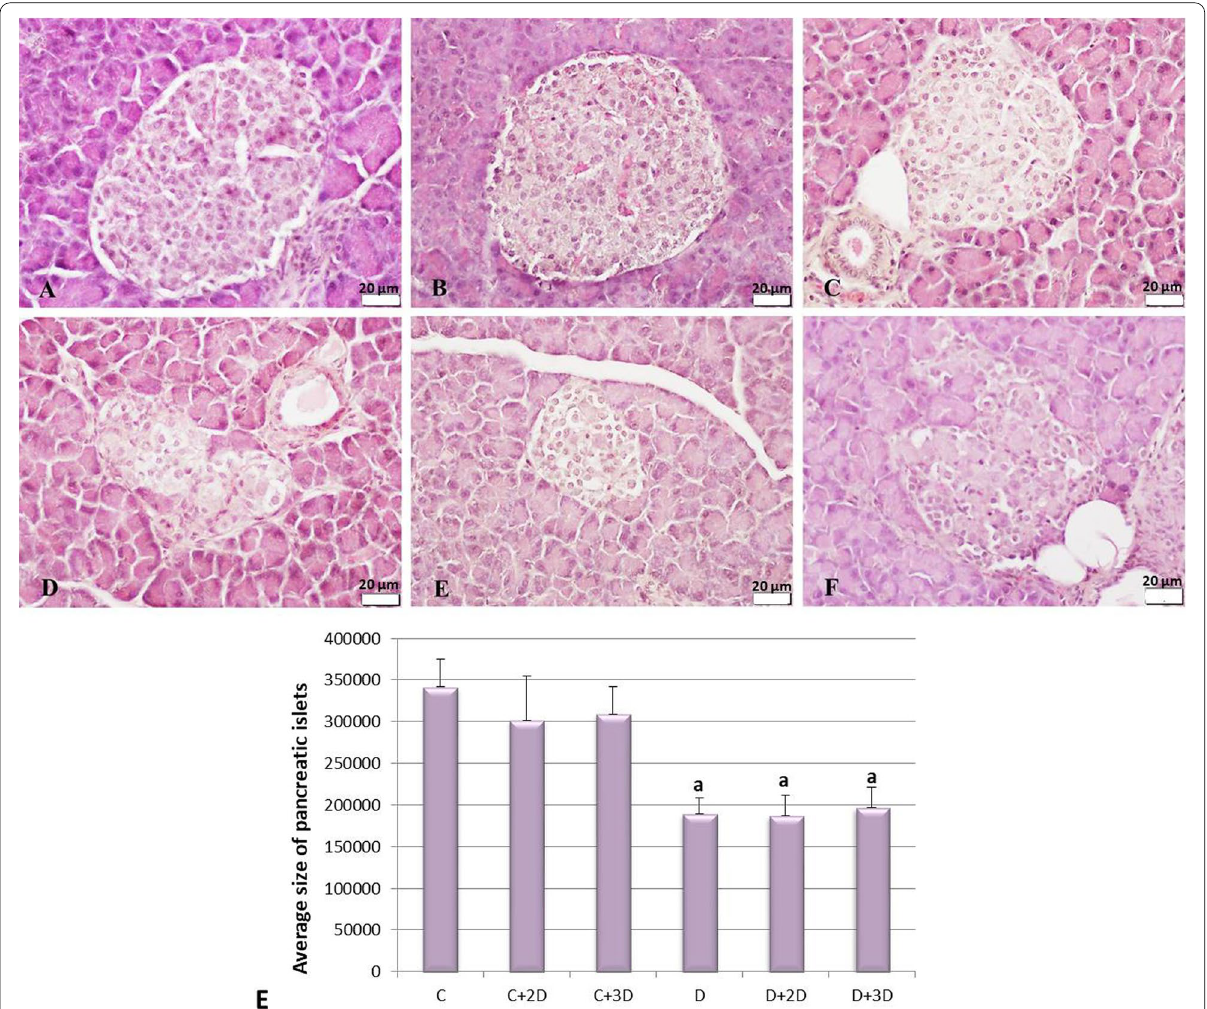
Fig. 5 Histological examinations. A C group. B C G Average size of pancreatic islets (pixels), a p < 0.05 versus the C